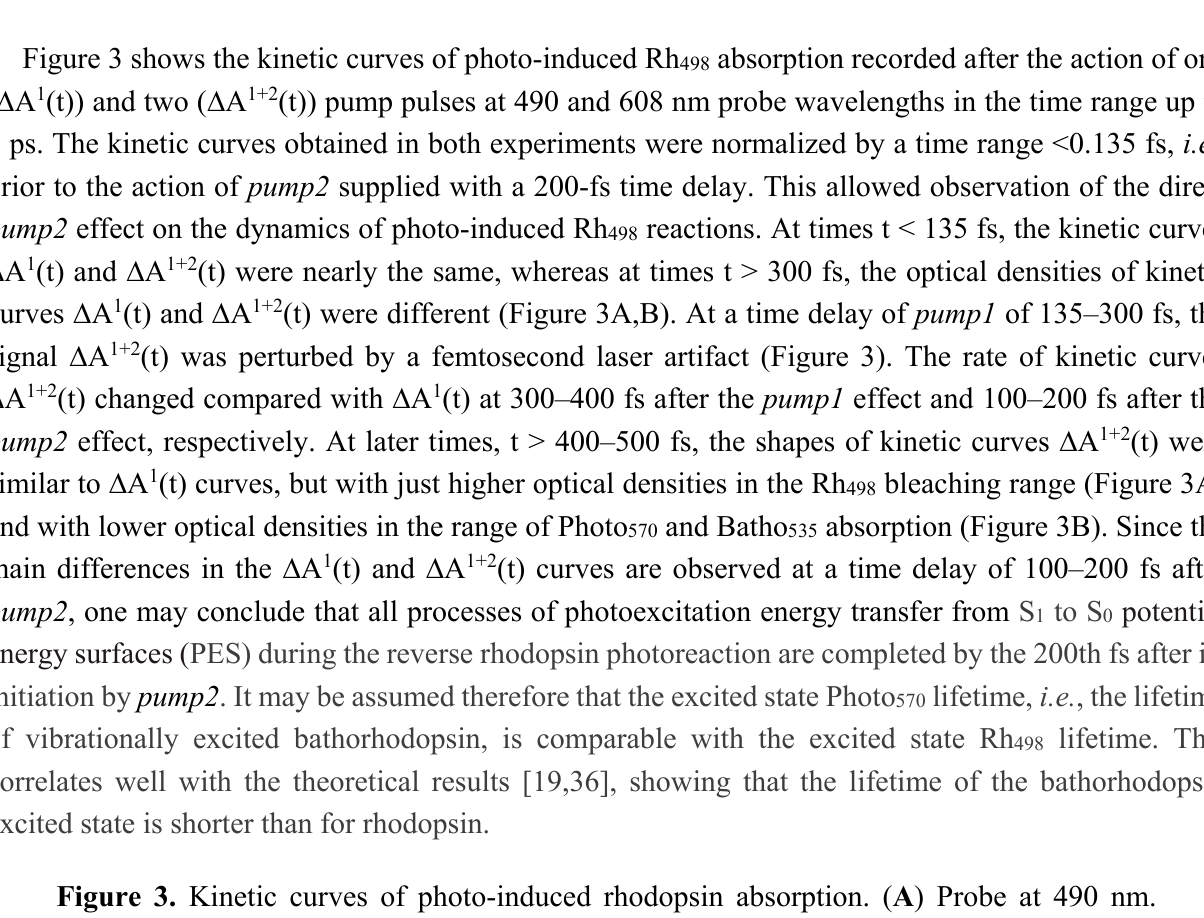
Figure 3. Kinetic curves of photo-induced rhodopsin absorption. ( А ) Probe at 490 nm. ( B ) Probe at 608 nm. Black kinetic curves were recorded after the action of one 25-fs pump1 at 500 nm. Grey curves were recorded after consecutive action of 25-fs pump1 at 500 nm and 30-fs pump2 at 620 nm following one another with a 200-fs time delay. These curves were normalized by the time range <0.135 ps (up to the pump2 occurrence